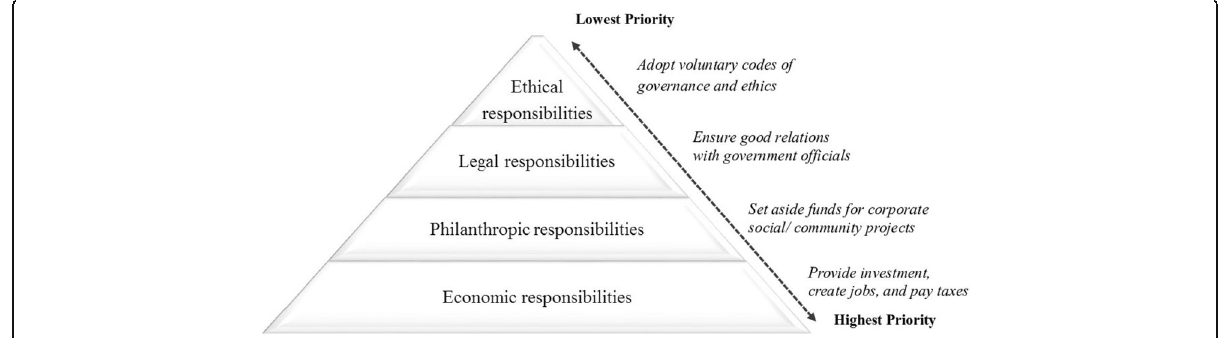
Fig. 7 Drivers of the CSR pyramid model for developing countries. Source: Visser (2006,